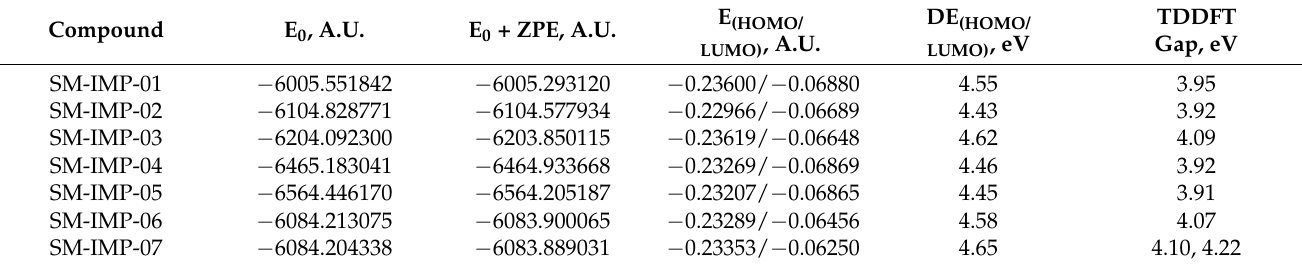
Table 1. Electronic energies without (E 0 ) and with zero-point (E 0 + ZPE) corrections, HOMO and LUMO energies (E (HOMO/LUMO) ), HOMO/LUMO gaps (DE (HOMO/LUMO) , and time-dependent DFT calculated (TDDFT) gaps, B3LYP/6-311+G(d,p), with implicit effects from